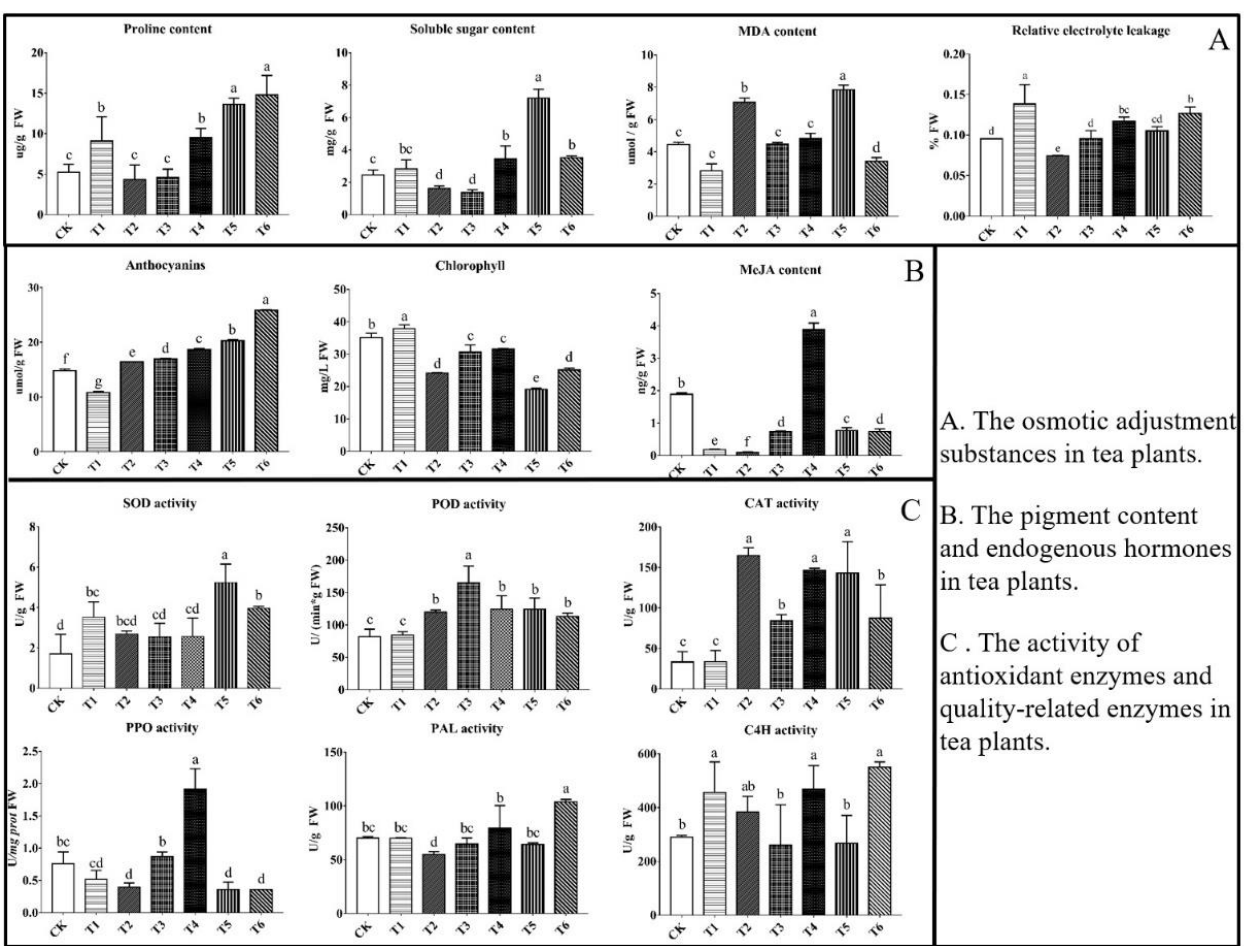
Figure 1. The effects of different treatments on resistance- and quality-related physiological indicators of tea plants. The error bars represent the standard error of the mean ± SD ( n = 3). Different lowercase letters indicate significant differences at p < 0.05. Noted: MDA: malondialdehyde; MeJA: methyl jasmonate; SOD: Superoxide Dismutase; POD: Peroxidase; CAT: Catalase; PPO: Polyphenol Oxidase; PAL: Phenylalanineammonialyase; C4H: Cinnamate 4 − Hydroxylase.